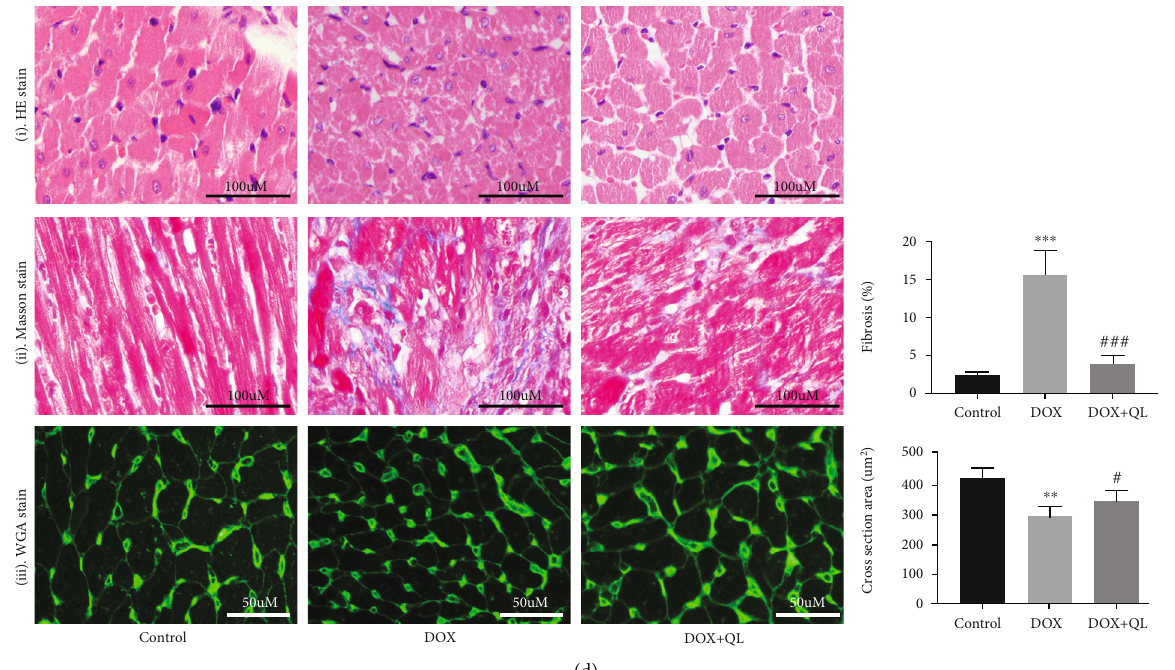
Figure 3: QL improved cardiac dysfunction and histopathological changes in rats under DOX exposure for 28 days. (a) Representative M- mode images of rats in di ff erent groups at the end of the experiment. (b, c) Left ventricular ejection fraction (EF%) and left ventricular fractional shorting (FS%) of rats in three groups on the 0th, 17th, and 31st day of the trial. (d) Histological analysis of heart tissues in three groups. (i) Representative HE staining displaying transverse myocardial section (300dpi, scale bar: 100 μ M). (ii) Masson staining of heart tissues. Collagen content was shown as fi brosis (300dpi, scale bar: 100 μ M). (iii) WGA staining of heart tissues (300dpi, scale bar: 50 μ M). Cardiomyocyte sizes were represented by cross-section areas (values are presented as mean ± SD ; ∗∗ P < 0 : 01 and ∗∗∗ P < 0 : 001 vs. control group; # P < 0 : 05 and ## P < 0 : 001 vs. DOX group; n = 5 per